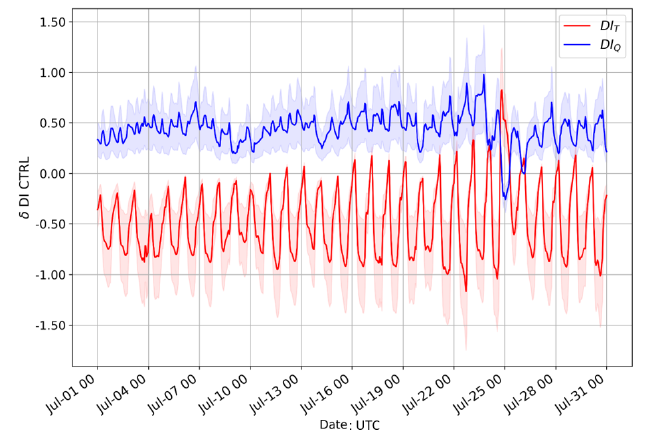
Figure 12. The differences with respect to DI CTRL of the temperature contribution (red) and the air moisture contribution